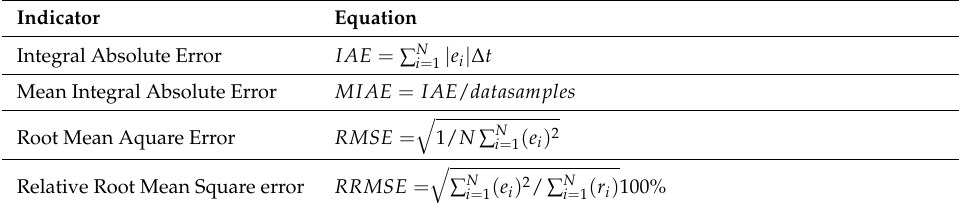
Figure 10. Error of predictions. Table 5. Tracking performance indicators’